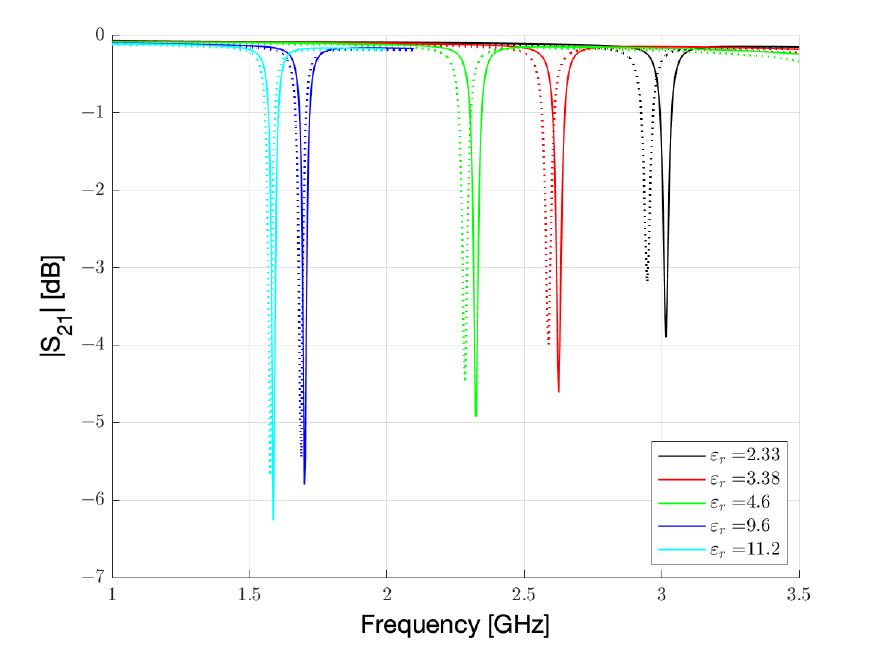
Figure 3. Simulated | S 21 | spectrum of the resonator reported in Figure 1 for the five substrates reported in Table 2. Continuous lines represent γ = 1 results. Dashed lines represent γ = 2